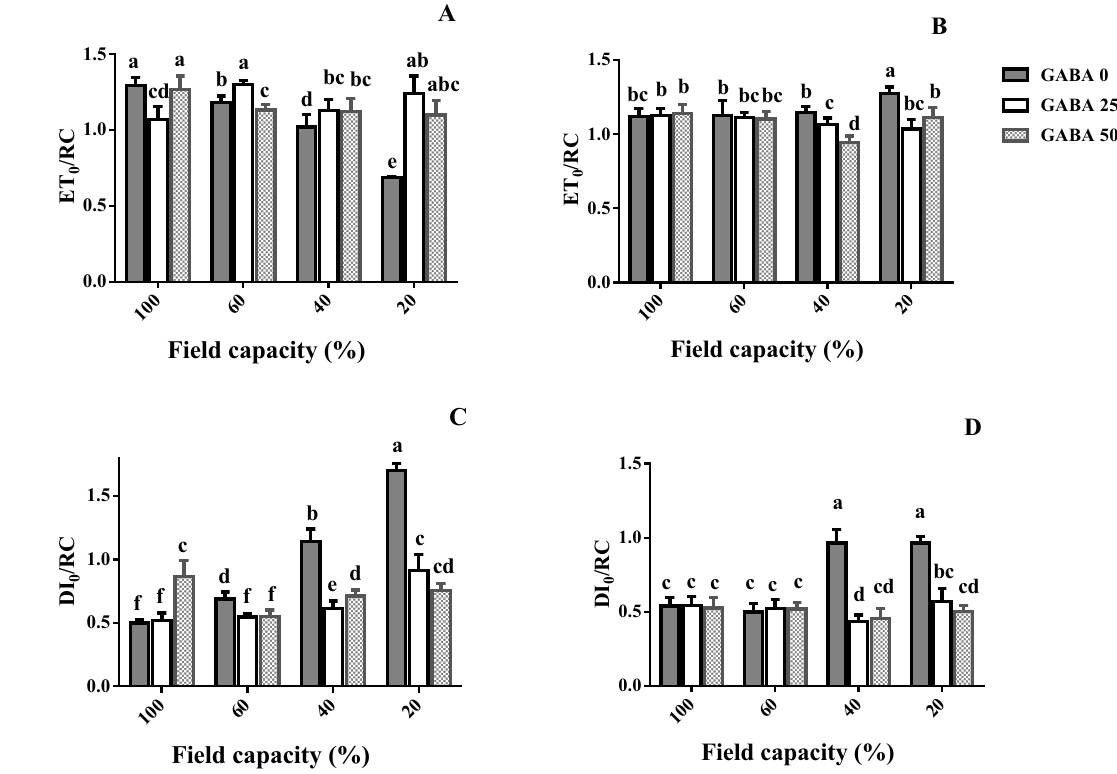
Figure 11. Leaf specific energy fluxes per reaction center for electron transport flux (ET 0 /RC; A , B ) and dissipated energy flux (DI 0 /RC; C , D ) of cv. Arman (tolerant; left panels) and cv. Azad (sensitive; right panels) chickpea plants receiving exogenous application of γ-aminobutyric acid (GABA) at different concentrations (0, 25 and 50 μM) under different watering levels (100, 60, 40 and 20% field capacity) during cultivation. Within each insert, different letters indicate significant differences. Error bars indicate SEM (n =